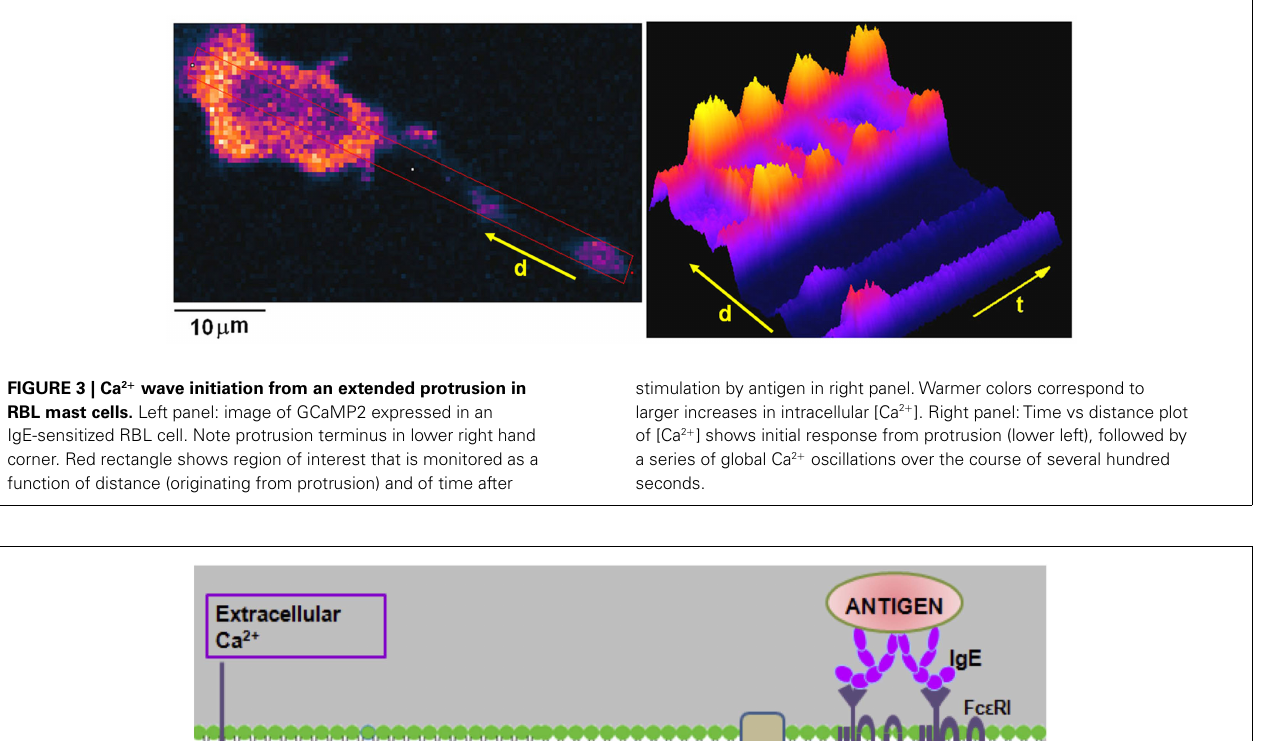
FIGURE 3 | Ca 2 + wave initiation from an extended protrusion in RBL mast cells. Left panel: image of GCaMP2 expressed in an IgE-sensitized RBL cell. Note protrusion terminus in lower right hand corner. Red rectangle shows region of interest that is monitored as a function of distance (originating from protrusion) and of time after